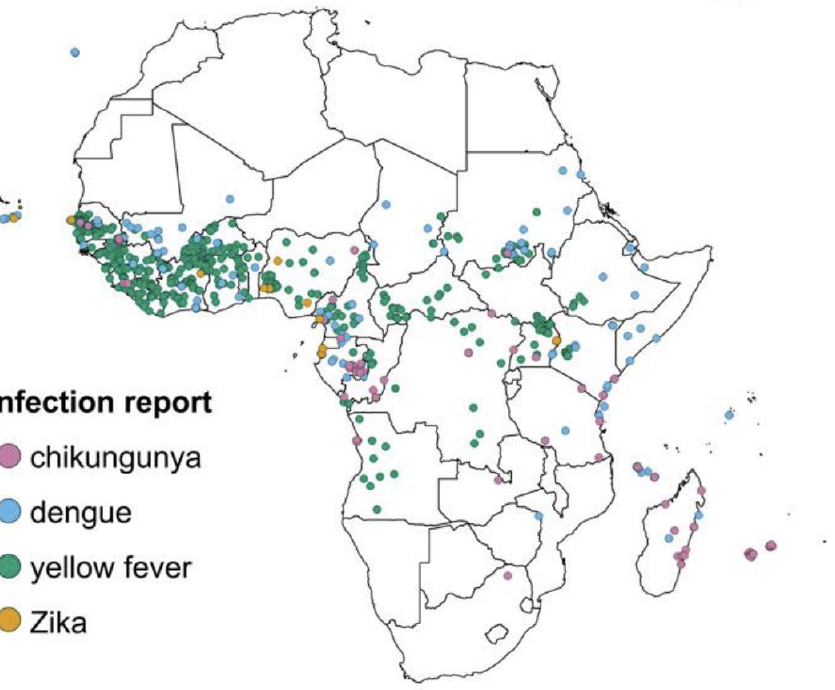
Figure 1. Locations of reported chikungunya, dengue, yellow fever and Zika infections in Africa. Source [12].